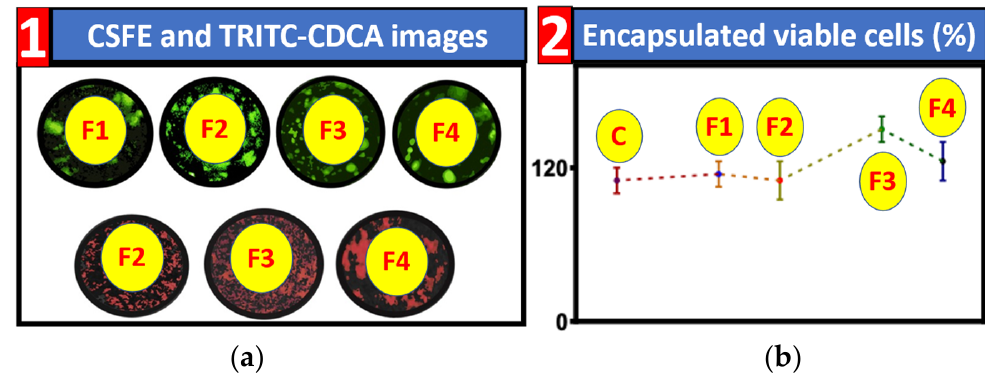
Figure 1. CFSE and TRITC-CDCA microscopic images and Encapsulated cell viability. ( a ). Top row Formulations 1 to 4 CFSE stained indicating distribution of MIN6 pancreatic β -cells in green. Bottom row TRITC conjugated CDCA images showing CDCA distribution in red. ( b ). Graph of % of viable cells post-encapsulation. The control is unencapsulated MIN6 pancreatic β -cells C. Graphed as as Mean ± SEM.